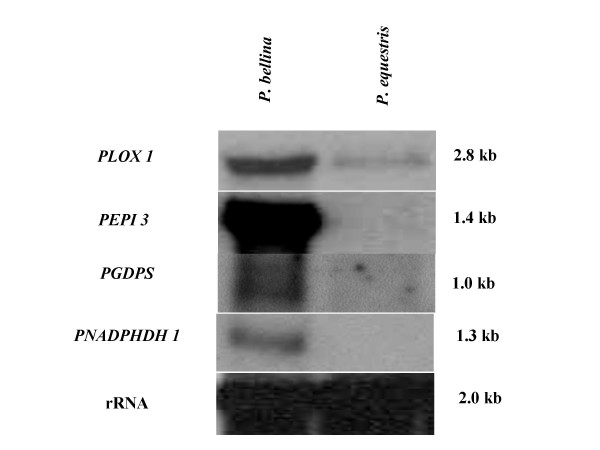
RNA gel-blot analysis of mRNA transcripts at day 3 pre-anthesis. RNA was extracted from day 3 pre-anthesis flower buds of P. bellina (lane 1) and P. equestris (lane 2) and analyzed for PLOX1, PEPI3, PGTPS and PNADPH-dehydrogenase 1 (PNADPHDH1) expression. The blots contained 10 μg of total RNA extracted from the different mature floral buds. The ribosomal RNA signals showed that the same amounts of total RNA were loaded on each individual lane.